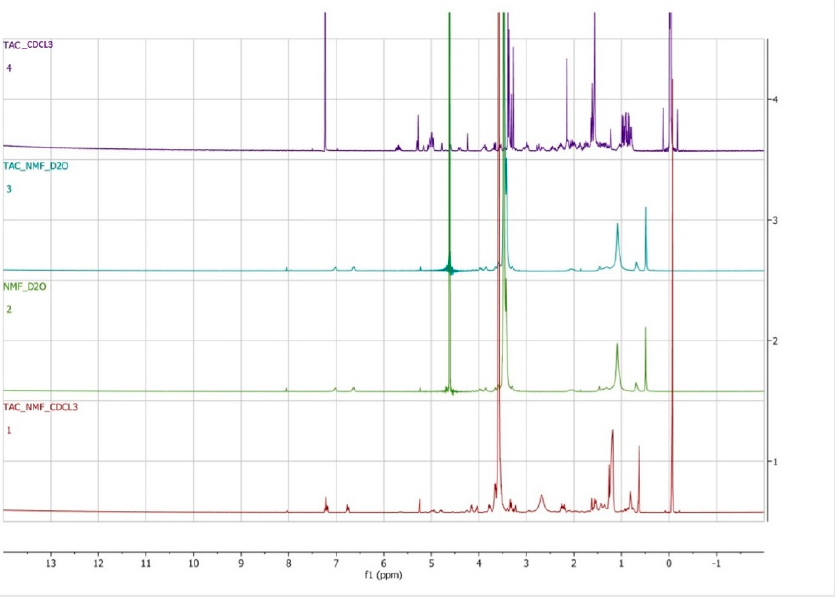
Figure 6. Qualitative 1 H NMR studies. (1) 1 H NMR spectrum for TAC drug in CDCl 3 , (2) 1 H NMR spectrum for TAC-NMF in D 2 O, (3) 1 H NMR spectrum for blank NMF in D 2 O and (4) 1 H NMR spectrum for TAC-NMF in CDCl 3.